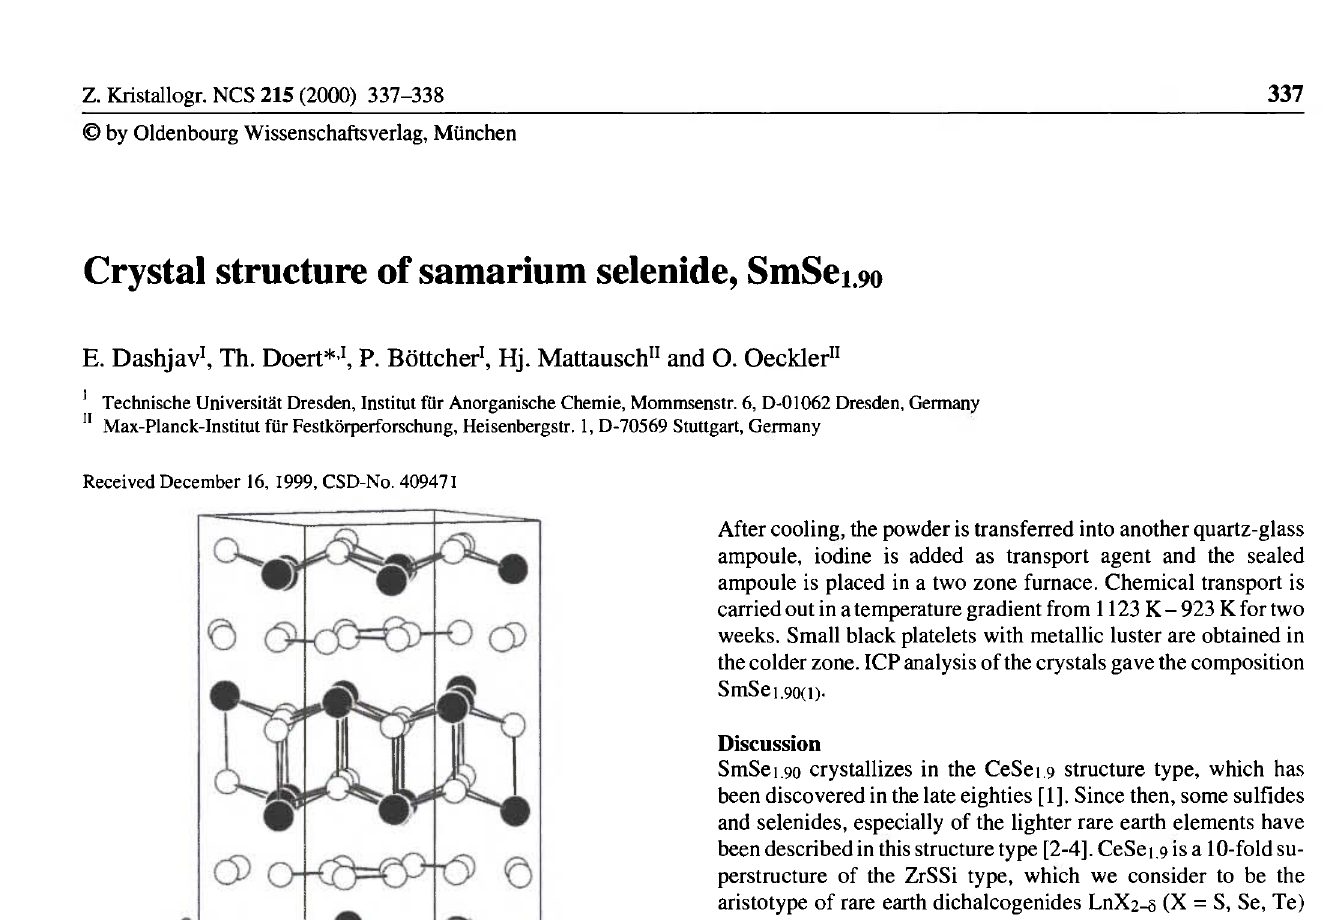
Fig. 1. Unit cell of SmSei.9; Sm atoms black, Se atoms open circles.